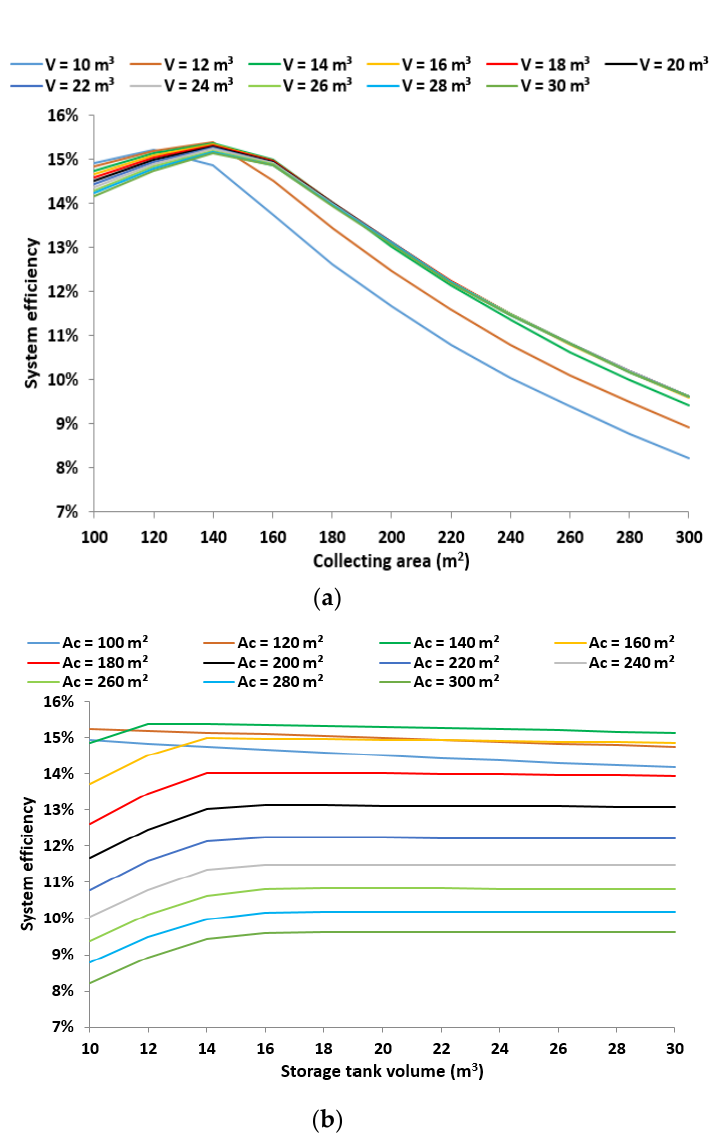
Figure 2. Electrical production ( a ) for different collecting areas with the storage tank volume as the main parameter ( b ) for different storage tank volumes with the collecting area as the main parameter.